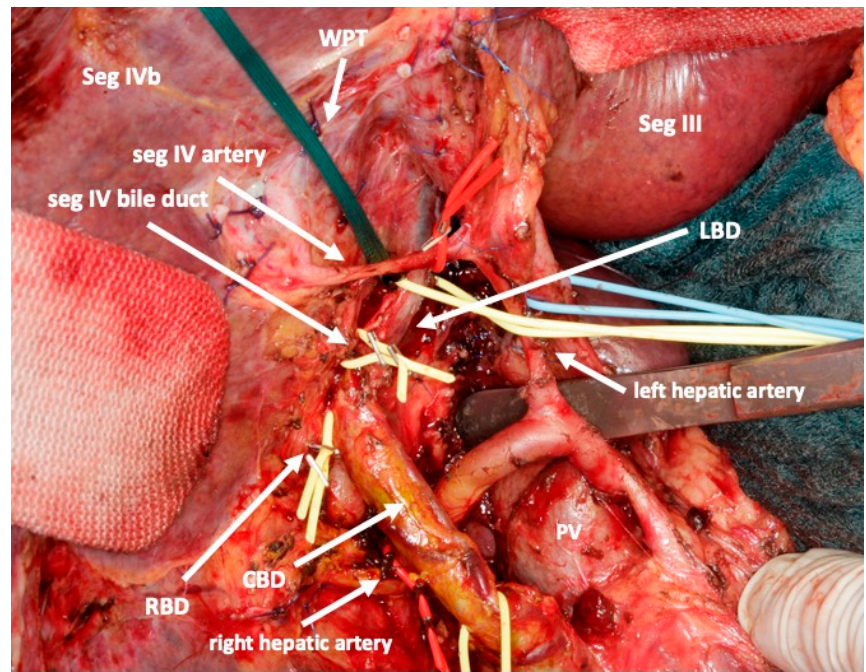
Figure 5. After transection of the liver and marking of the middle and left hepatic veins, all vessels to the right and caudate lobe in the hilum that need to be divided during the second operation are marked with red or yellow vessel loops. Only arteries and bile ducts are remaining. (woven polyester